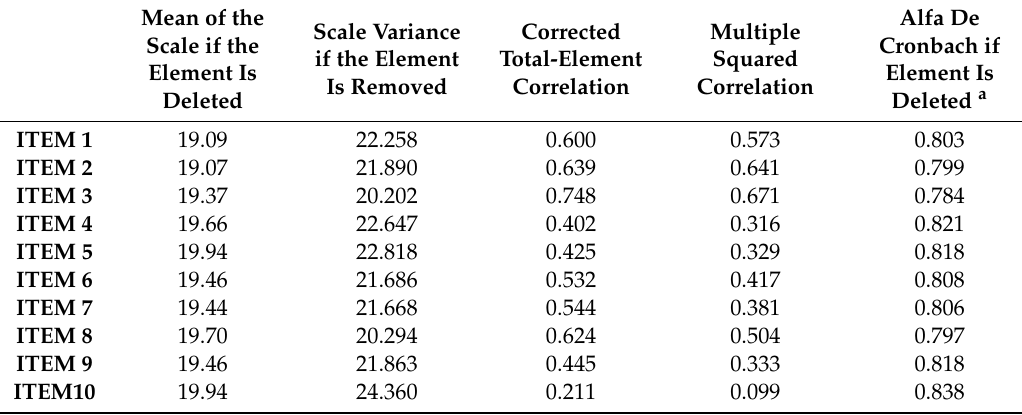
Table 4. Item analysis of the Spanish version of the Fonseca anamnestic index.